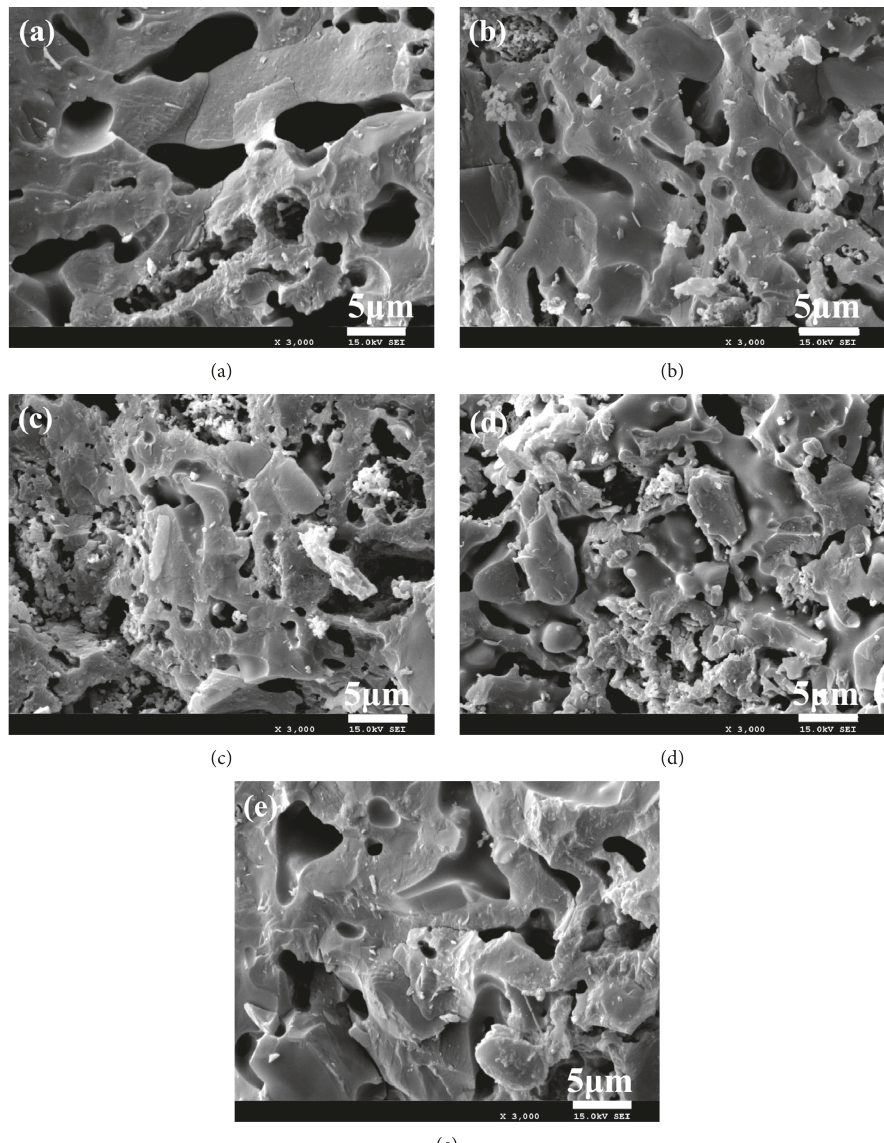
Figure 7: Microstructures of ceramics with different additions at the sintering temperature of 1100 ° C: (a) no addition, (b) 15% vanadium- titanium slags, (c) 6% Fe 2 O 3 , (d), 1.5% TiO 2 , and (e) 0.9% MnO 2